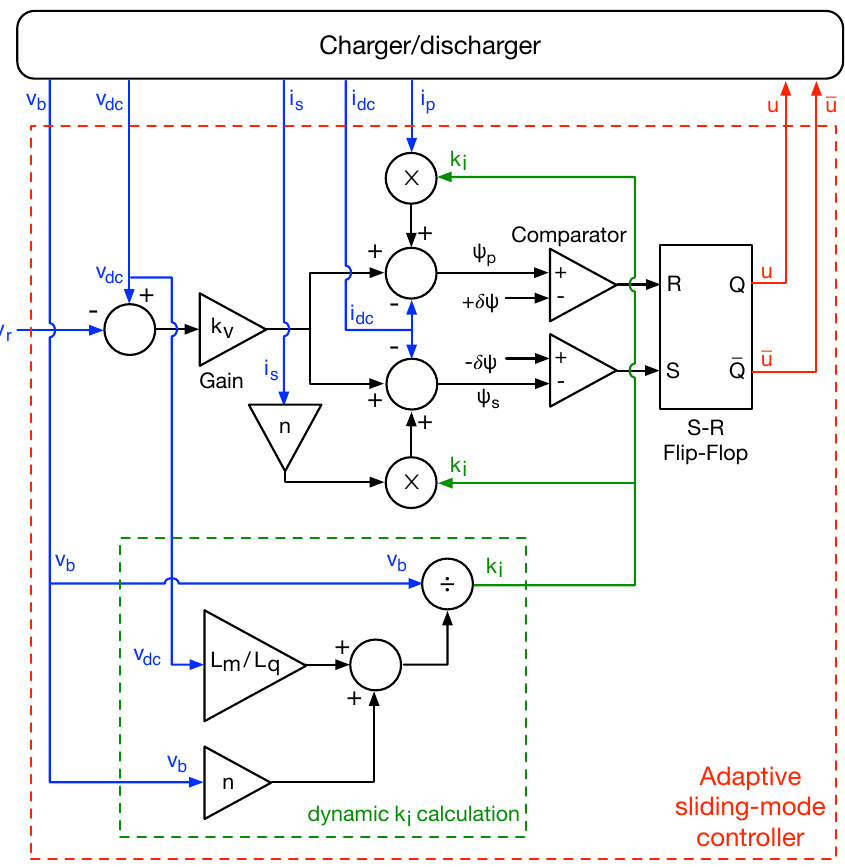
Figure 3. Proposed sliding-mode controller for the battery